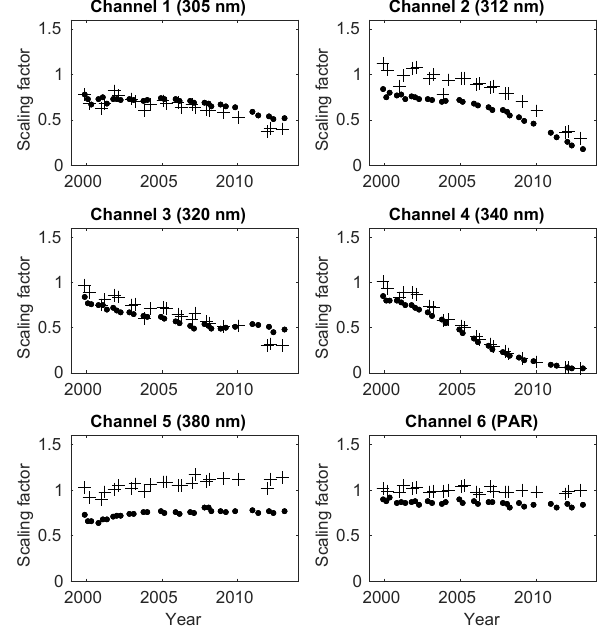
Figure 3. Scaling factors of the UV channels of the Ushuaia ( · ) and Marambio ( + ) NILU-UV instruments.